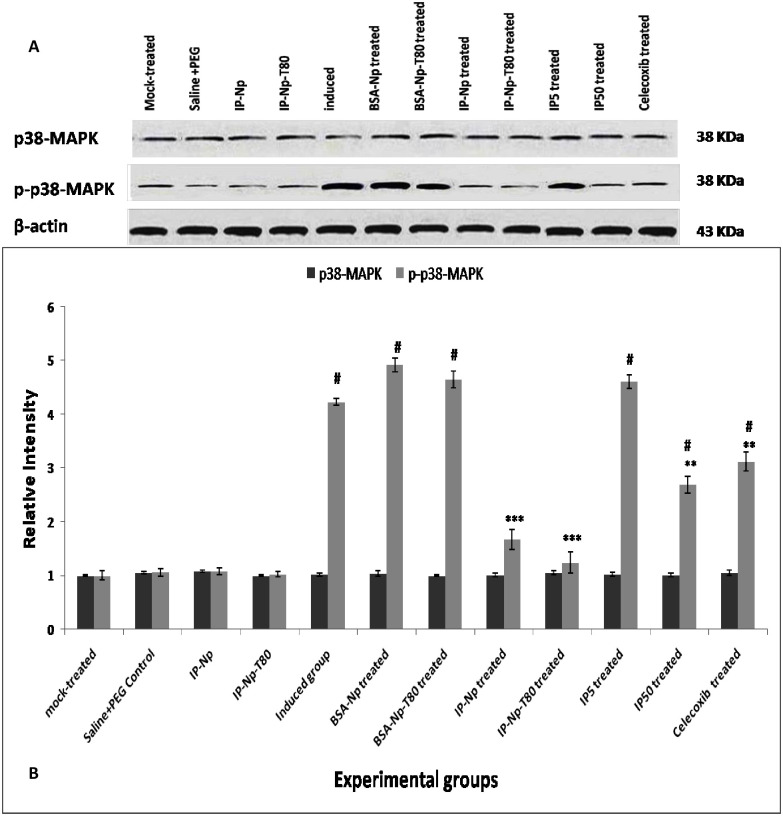
Alterations in brain (hippocampus) protein levels of p38-MAPK and phosphorylated p38-MAPK of LPS-induced and treated groups versus control groups.A) Representative western blotting analysis of p38-MAPK and p-p38-MAPK proteins. B) Representative Histogram of relative intensity of p38-MAPK and p-p38-MAPK using β-actin as internal control. Data represented as mean ± SD and p value is statistically significant at (***p≤0.001, **p≤0.01, *p≤ 0.05) compared to induced group and (#p≤ 0.05) compared to mock-treated group.